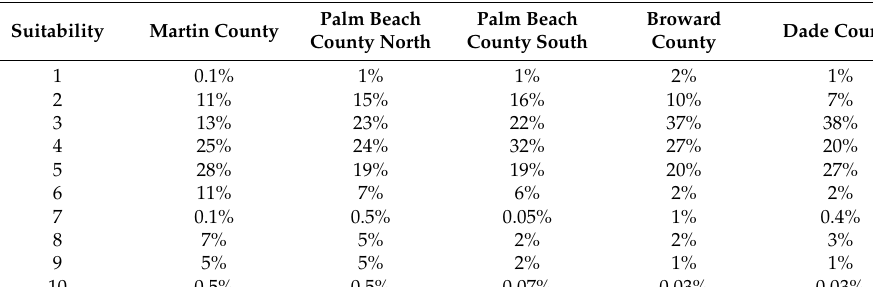
Table 4. Nesting suitability for each section.